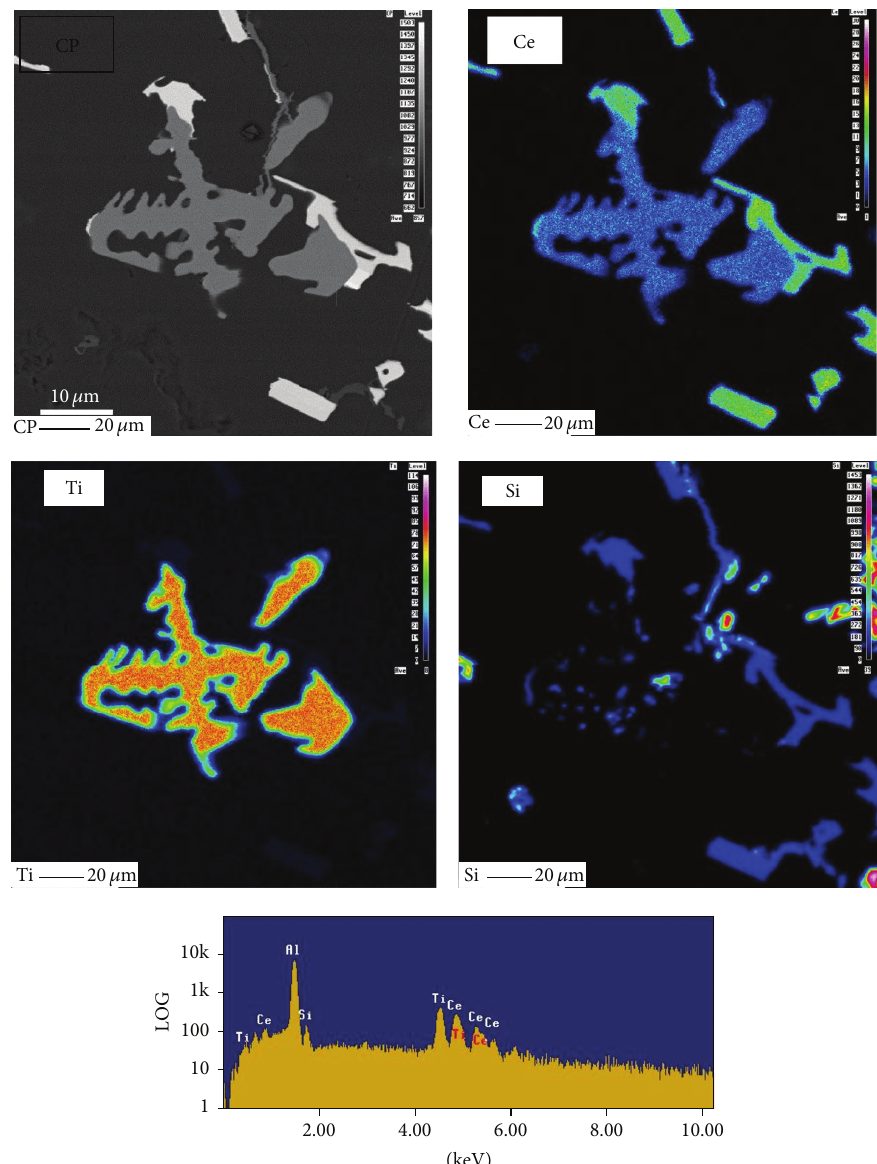
Figure 13: Precipitation of complex intermetallics in T6S